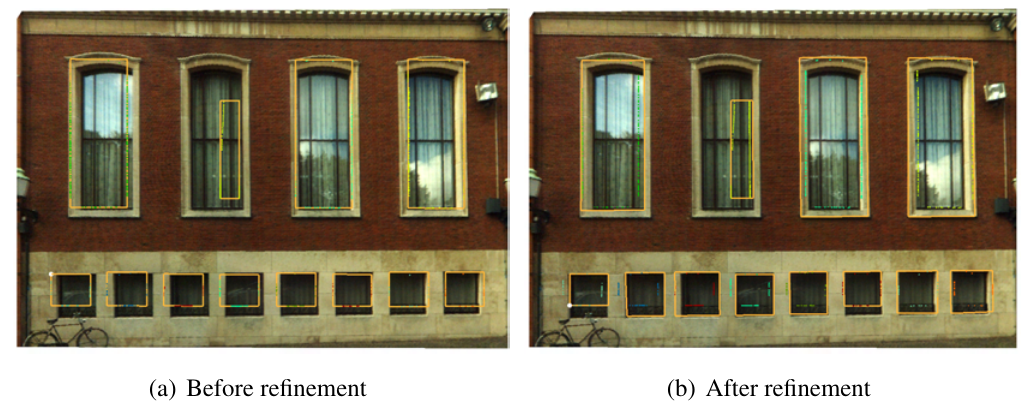
Figure 9. Refining the window outlines of a building